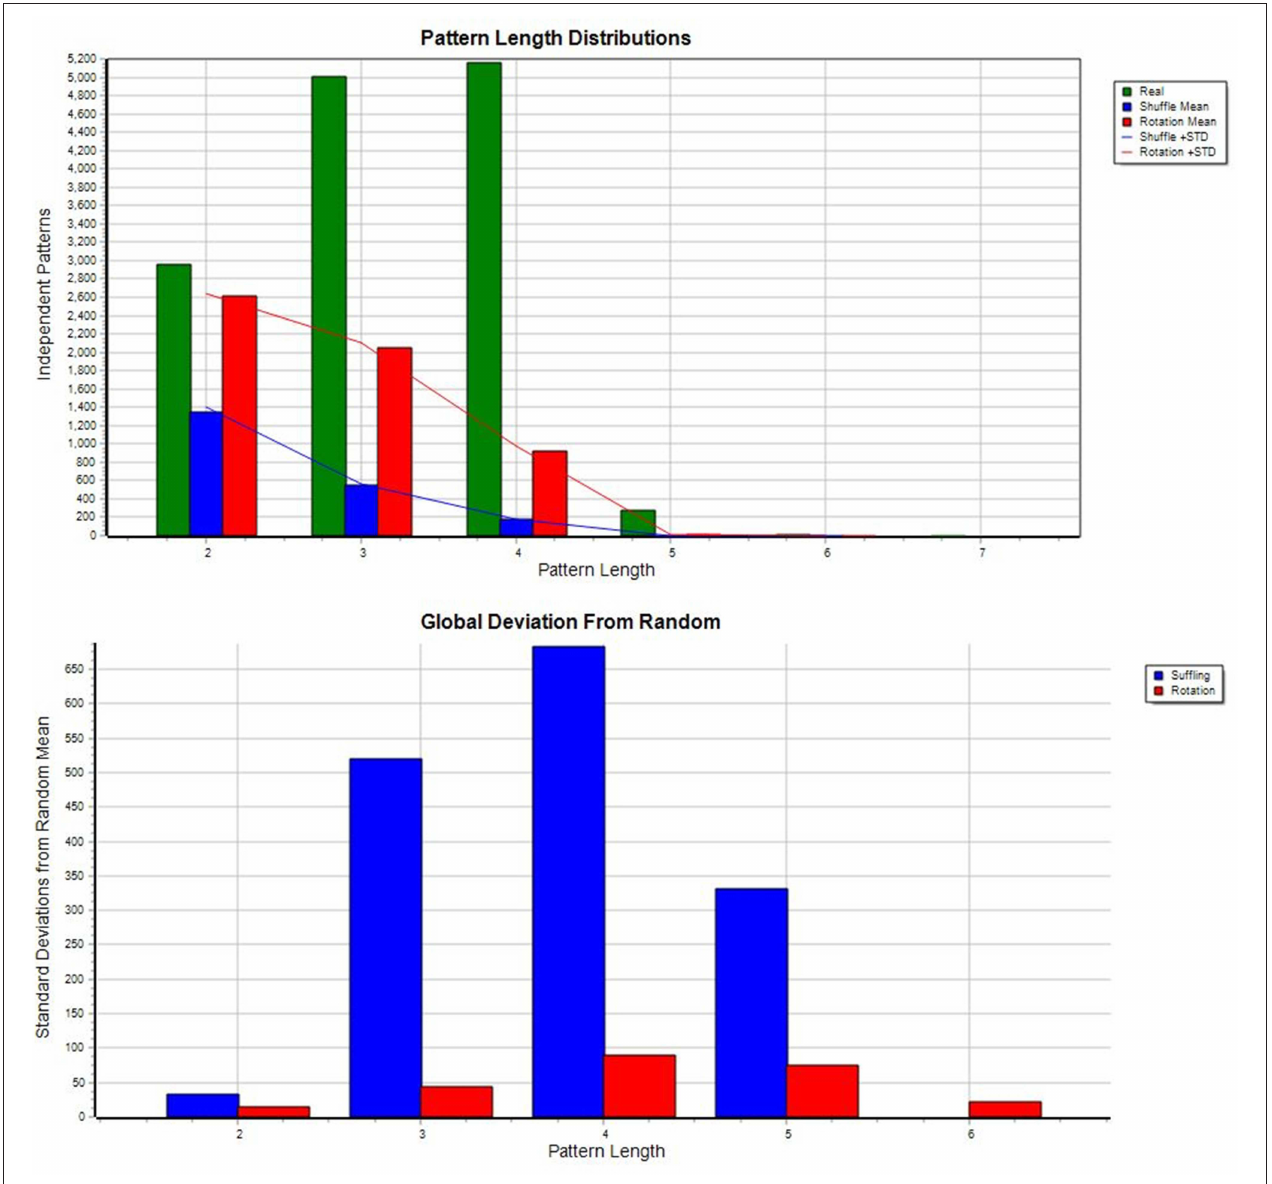
FIGURE 1 | Real vs. random (Upper) and devition from random (Below) using file: